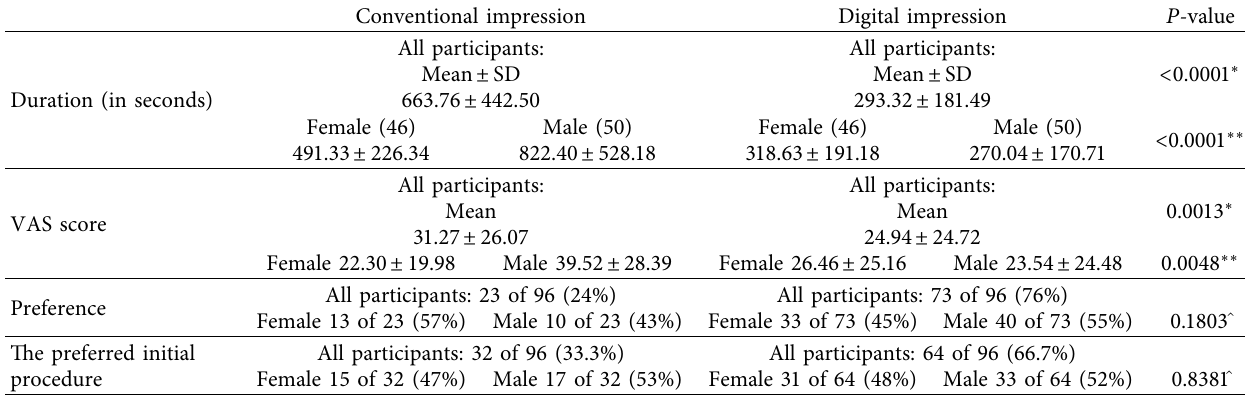
Table 2: Comparison between conventional and digital